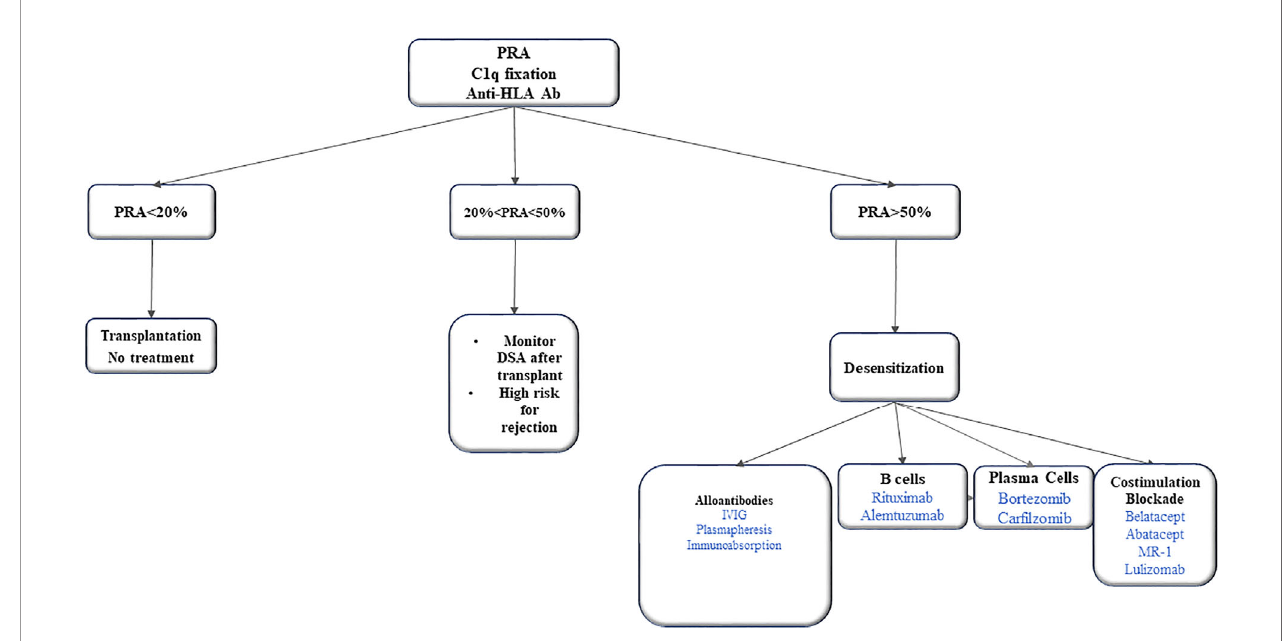
FIGURE 1 | Desensitization strategies in